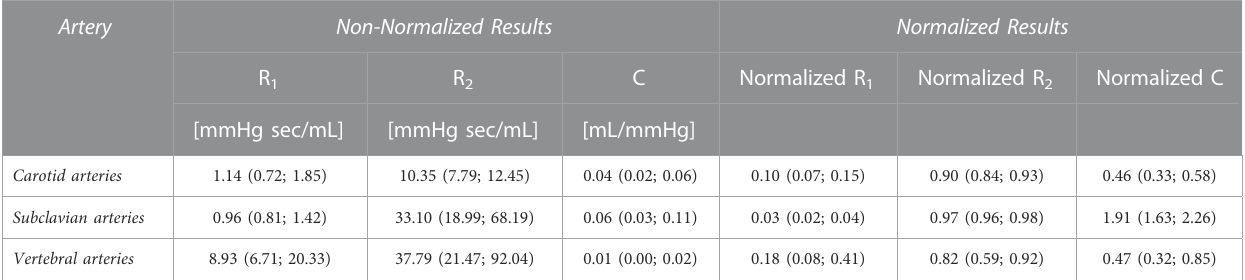
Artery Non-Normalized